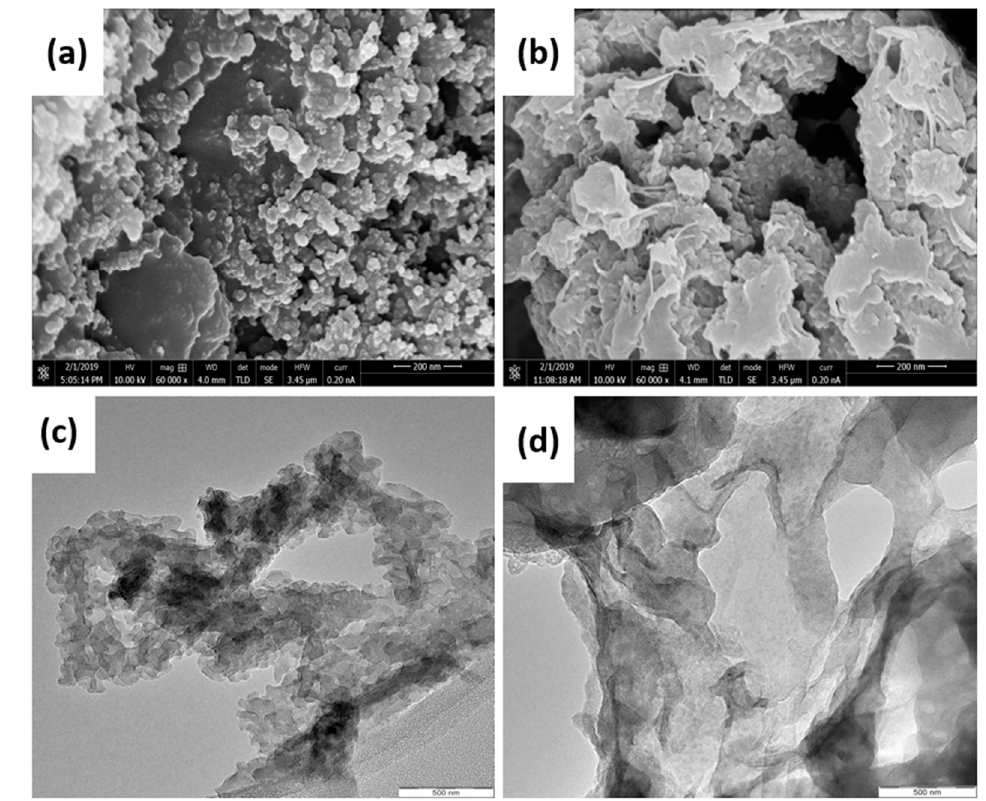
Figure 4. ( a ) Scanning electron microscopy (SEM) image of GO; ( b ) SEM image of GO-PANI nanocomposite; ( c ) transmission electron microscopy (TEM) image of GO; ( d ) TEM image of GO-PANI nanocomposite.